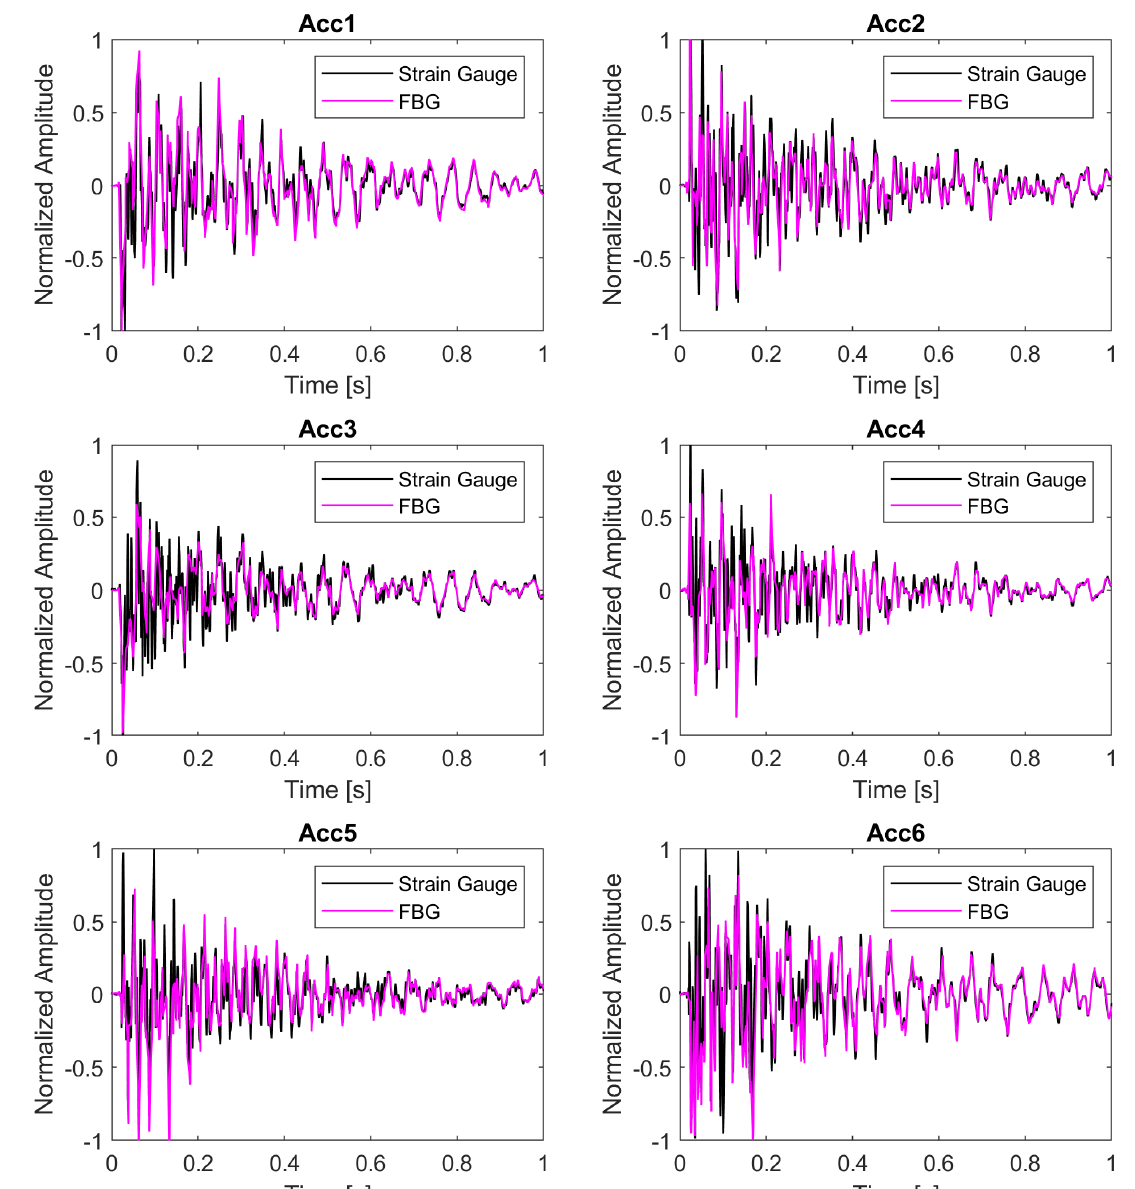
Figure 5. Examples of synchronization plots between FBG 8 and the SG. Both graphs provide similar information, even if extra noise is present in the optical fiber plot. Moreover, the results were compared with preliminary available FEM results [73], showing a satisfactory agreement between experimental data and numerical results (ob- tained from the first FEM model, non-validated), with the only exception being the sixth mode, as reported in Table 3 where percentile variations are computed with respect to the DMT results, taken as